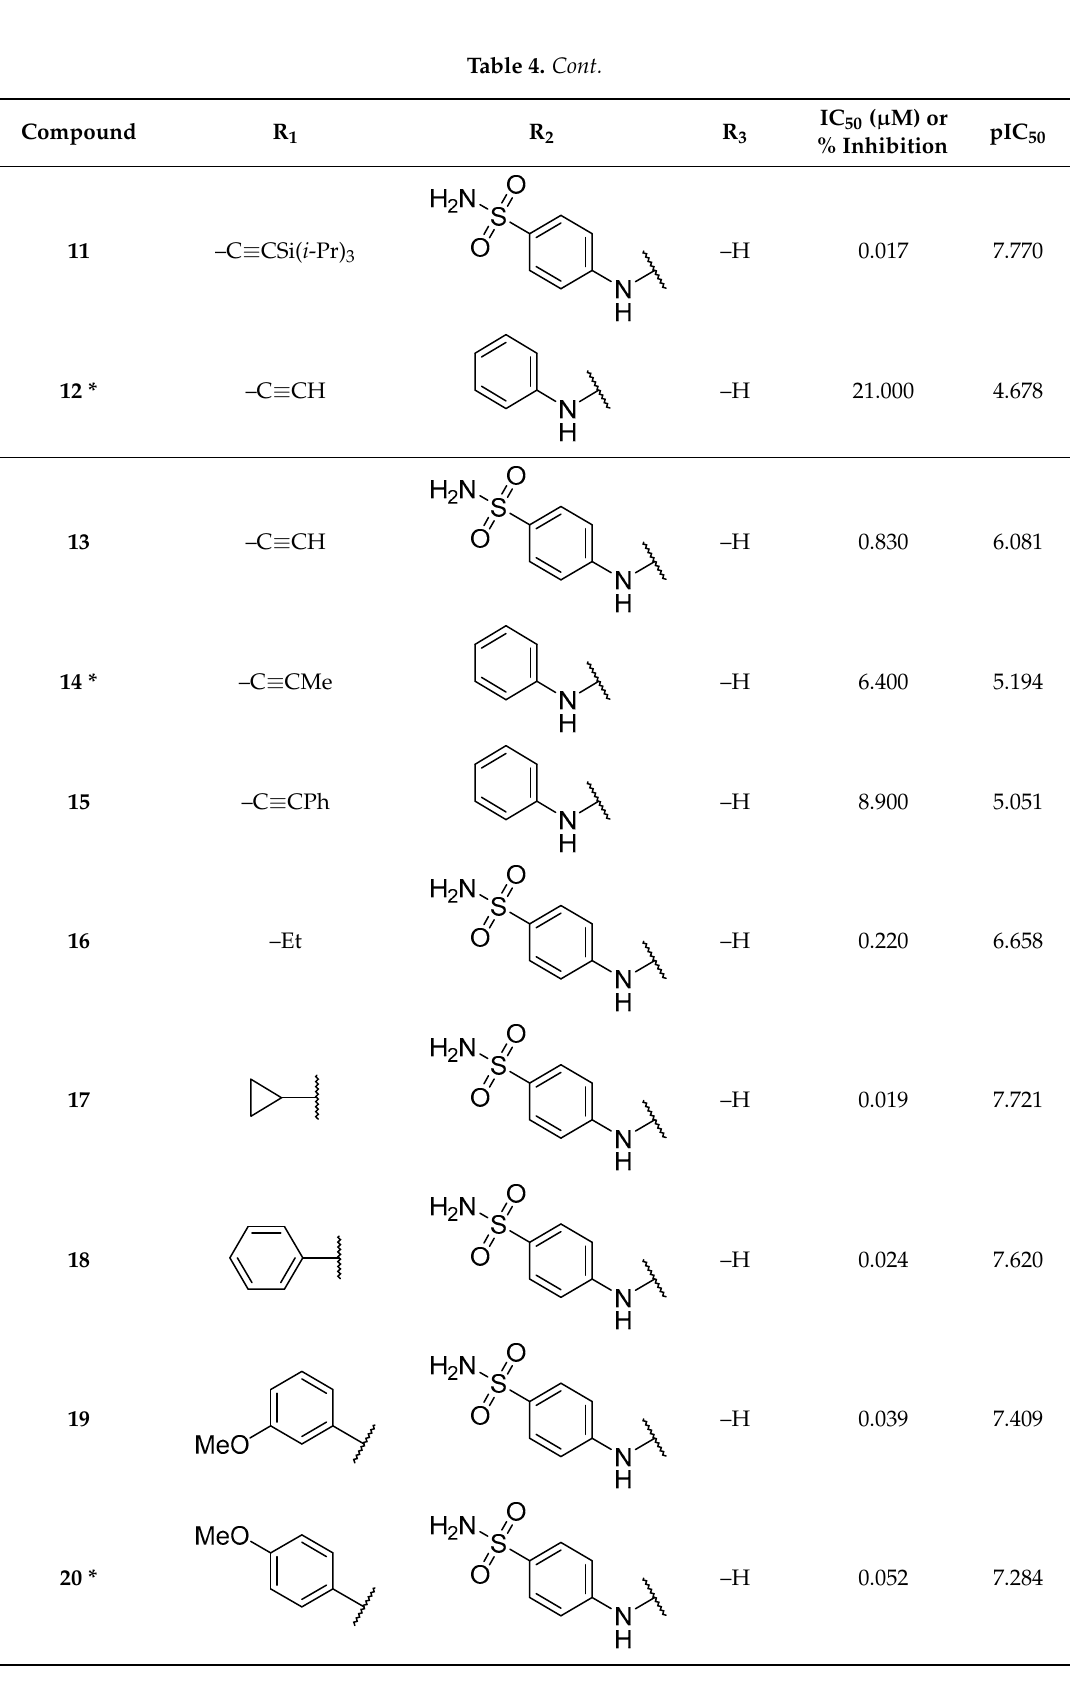
Table 4. The structures and the pIC 50 values of the dataset compounds.